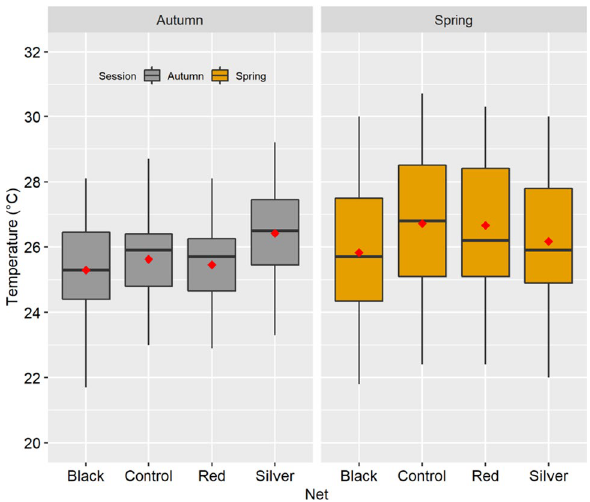
Figure 1. The average temperature variability within the photo-selective screen structures during the cultivation period (30 days) of the lettuce in the autumn and spring